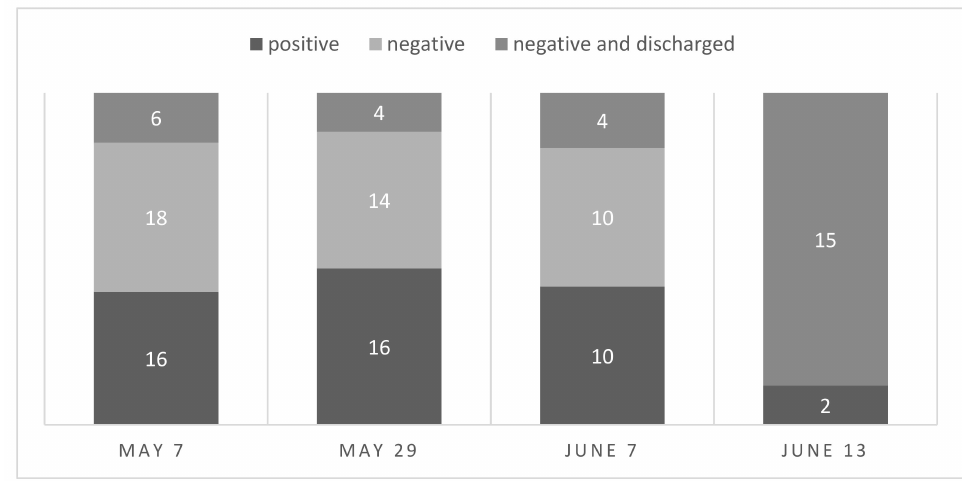
Figure 2. PCR positive and negative results of quarantine populations at different dates.